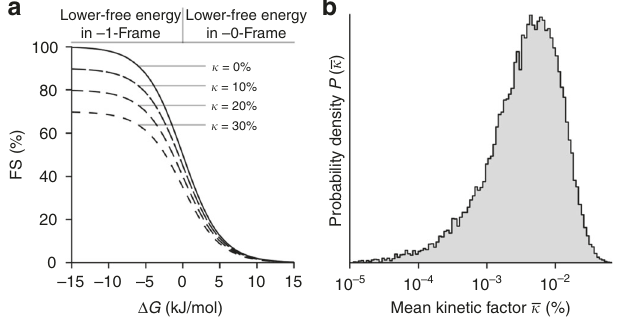
Fig. 3 Kinetic contribution to the frameshifting ef fi ciency. a FS as a function of the free-energy difference Δ G between 0-frame and − 1-frame for different kinetic factors κ , where κ = 0% corresponds to frameshifting in equilibrium. b Probability density for the mean kinetic factor, obtained from a modi fi ed free-energy model that takes into account kinetic barrier crossing between 0-frame and